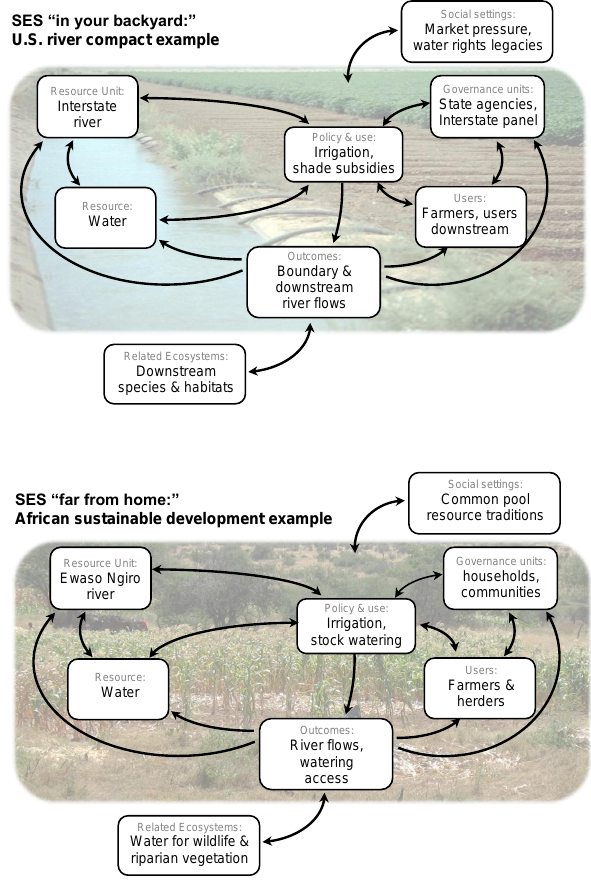
Fig. 3. SES schematic of human-environment system, illustrated with variables specific to the water compact example (a) , and the Kenyan river ecohydrology example (b) from the text discussions of potential hydrology assignments “in your backyard” and “far from home,” respectively. Photo credits: (a) US Bureau of Reclamation, (b) E. G.